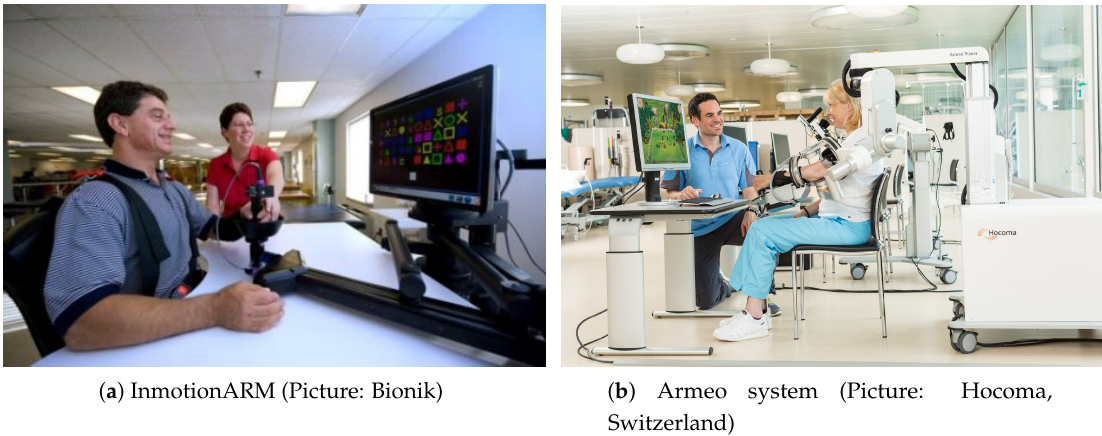
Figure 2. Systems for upper limb rehabilitation, commercially